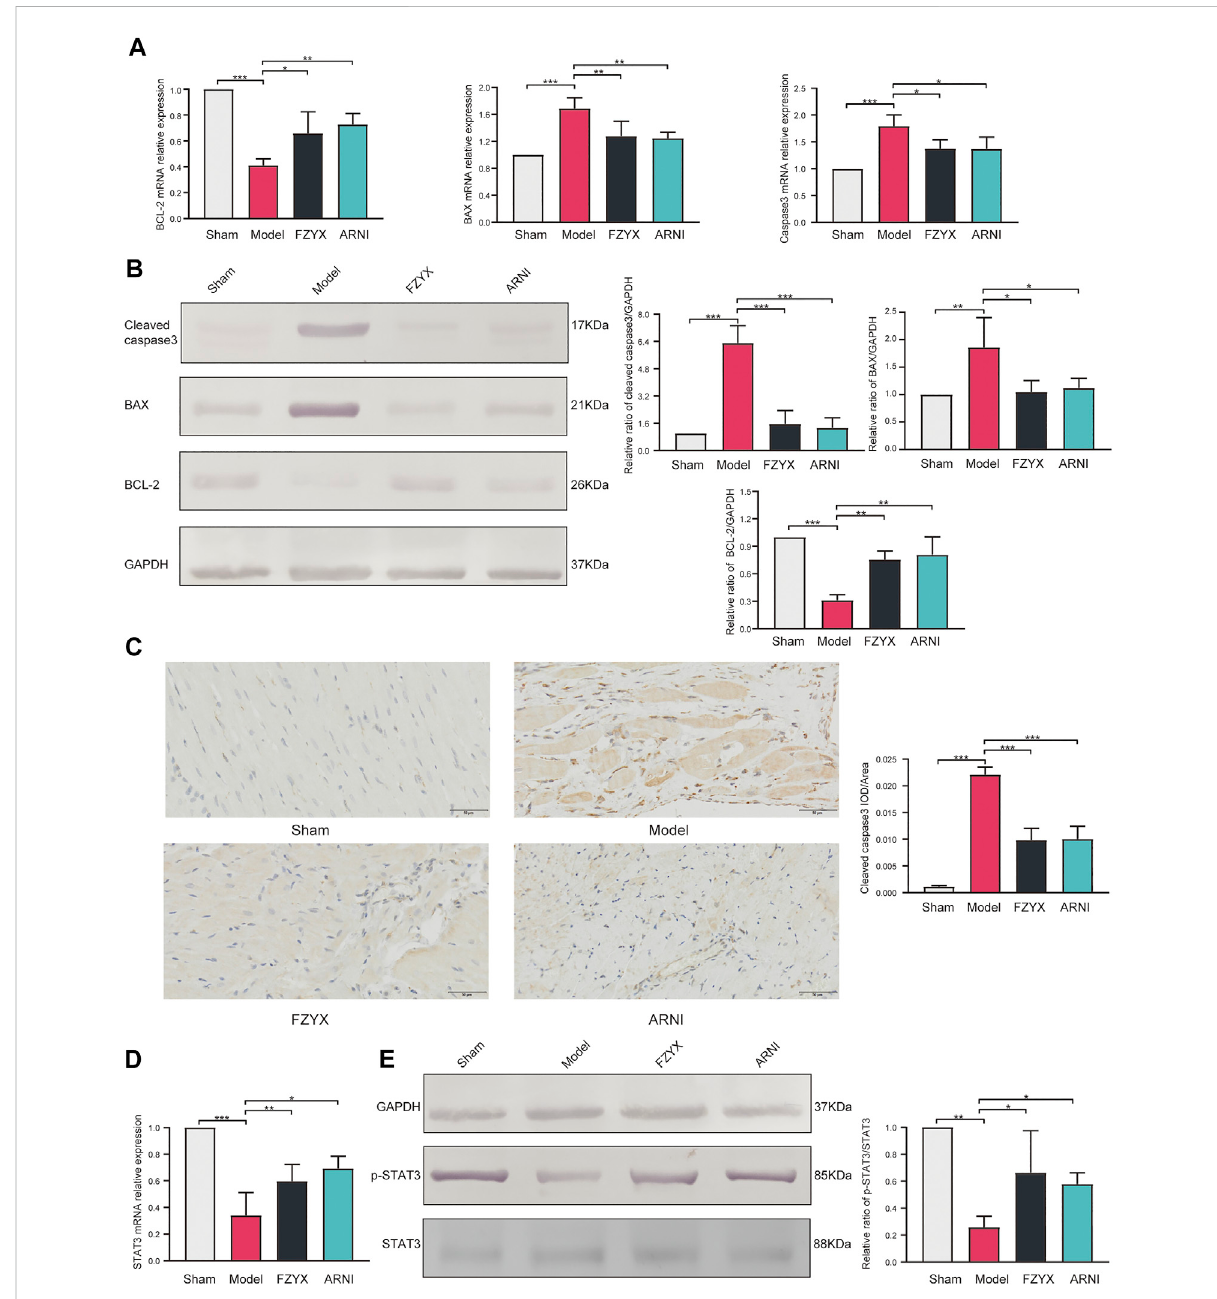
FIGURE 7 Regulation of apoptosis and STAT3 by FZYX. (A) mRNA expressionlevels of BCL-2, BAX and Caspase-3 ( n = 3). (B) Protein abundance ofBCL-2, BAX and Caspase-3 ( n = 3). (C) immunohistochemical analysis of Caspase-3 ( n = 5). (D) mRNA expression levels of STAT3 ( n = 3). (E) Protein abundance of pSTAT3 and STAT3 ( n = 3). * p < 0.05, ** p < 0.01, *** p < 0.001 vs.